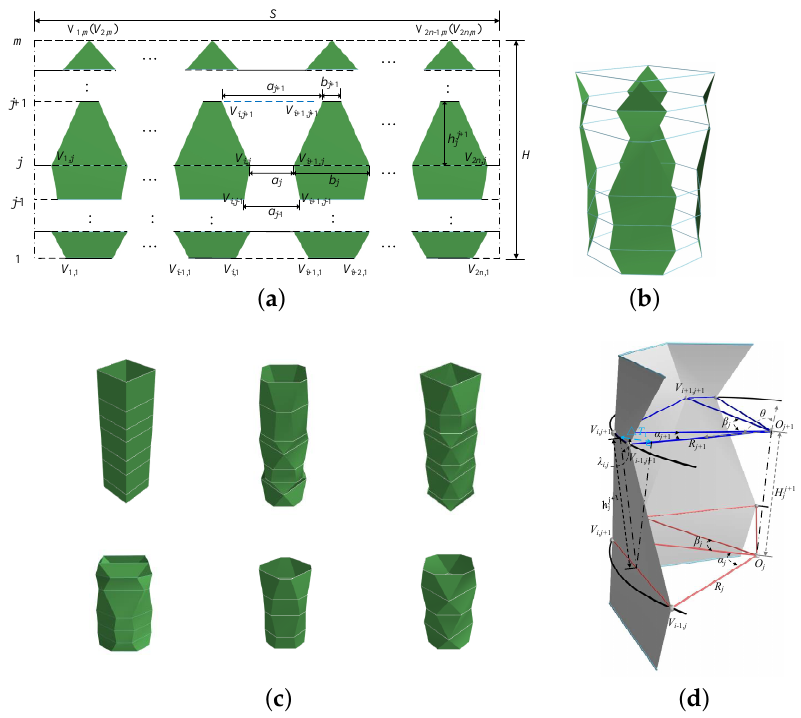
Figure 2. An origami tube with variable crease multi–forms: ( a ) the crease pattern for multi–shape origami tube, where V i , j is vertex of the i th point in the j th layer ( i = 1,2, . . . ,2 n , j = 1,2, . . . , m ), h j is the height of each layer when unfolded, the j th layer is formed alternately by n edges of a j and n edges of b j , S and H are the total length and total height, respectively, under the expanded state; ( b ) an origami tube obtained from crease patterns; ( c ) origami tubes with several different crease shapes; ( d ) 3D view of the key creasing parts, where O j is the center of the circumscribed circle of the j th layer, R j is the radius of the circumscribed circle of the j th layer, and α j and β j are central angles corresponding to a j and b j , respectively. λ i , j is the collapsible angle between adjacent layers, and ∆ T is the folding angle of the same